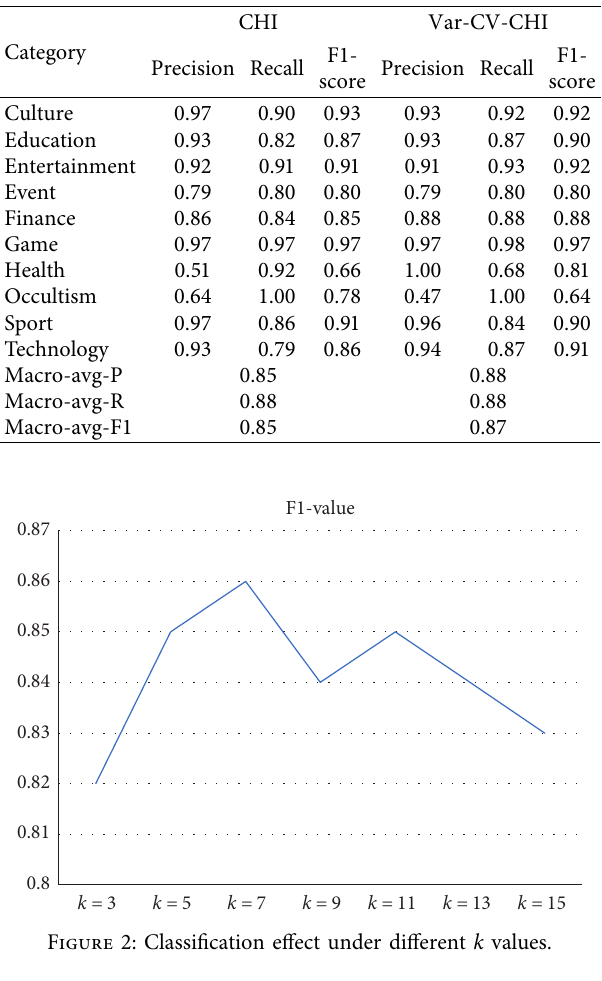
Table 5: Comparison of classification results between CHI and Var-CV-CHI on the unbalanced Chinese corpus (KNN).